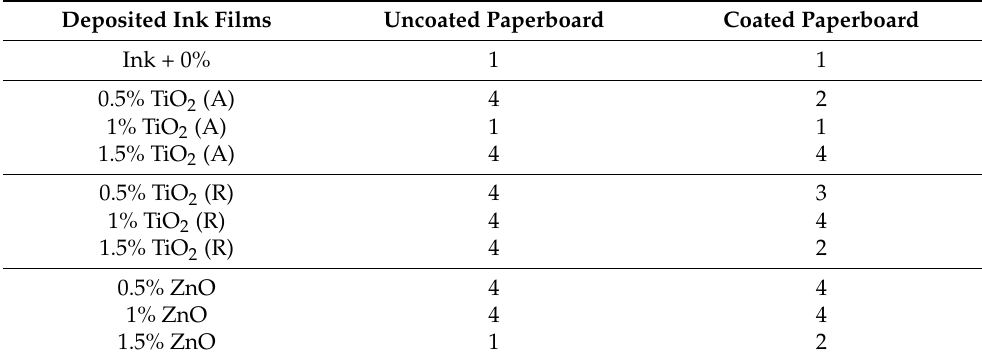
Table 5. Results of the visual assessment of rub resistance. Deposited Ink Films Uncoated